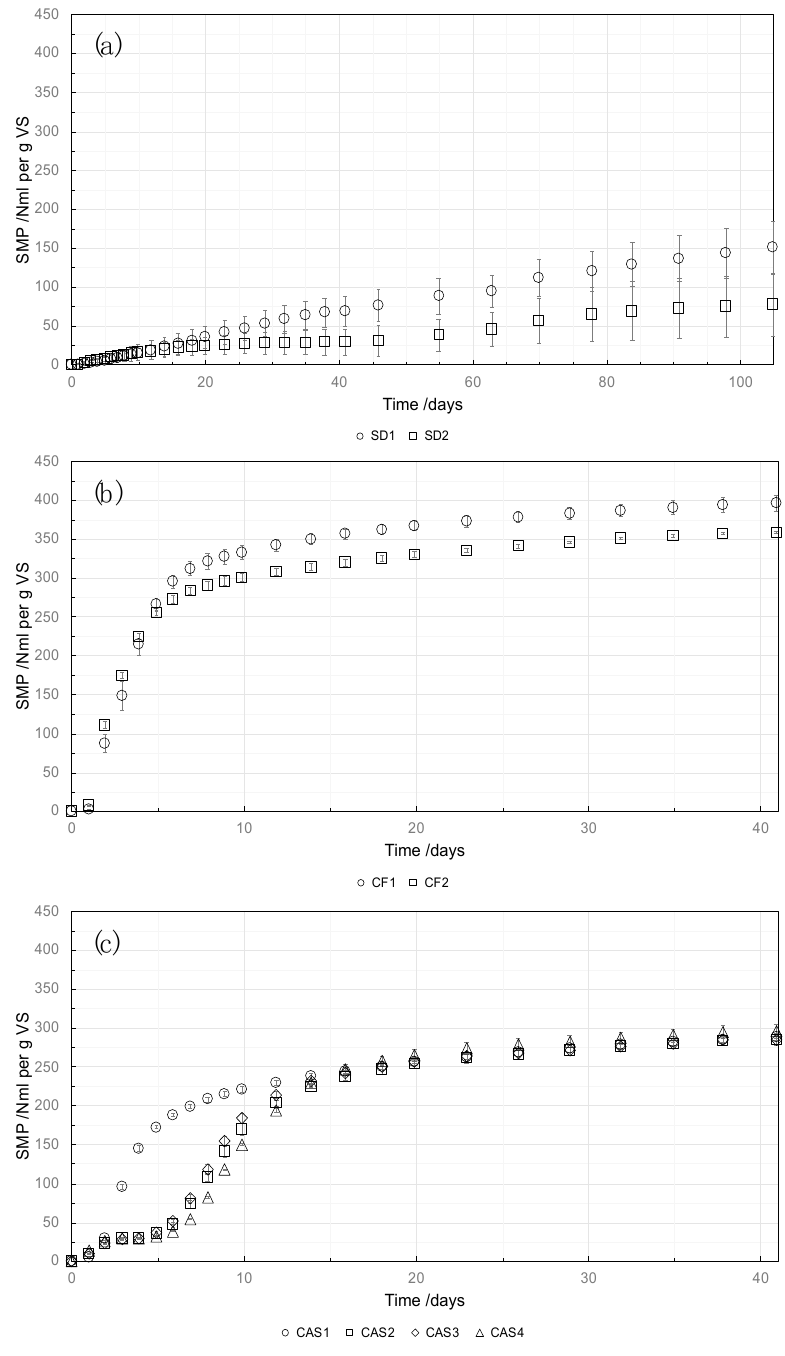
Figure 2. Specific methane production (SMP) curves for the substrates obtained by manometric measurement. Error bars show standard deviation of triplicates of each substrate. ( a ): SD1 = coconut sawdust, SD2 = jambolan sawdust; ( b ): CF1 = mixed cassava fiber, CF2 = pressed mixed cassava fiber; ( c ): CAS1 = Chinhembue cassava peels, CAS2 = Cussi cassava peels, CAS3 = Cizangara cassava peels, CAS4 = Nhassumbi cassava